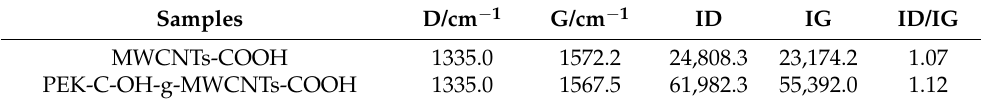
Table 1. Raman spectra data of MWCNTs-COOH and PEK-C-OH-g-MWCNTs-COOH.